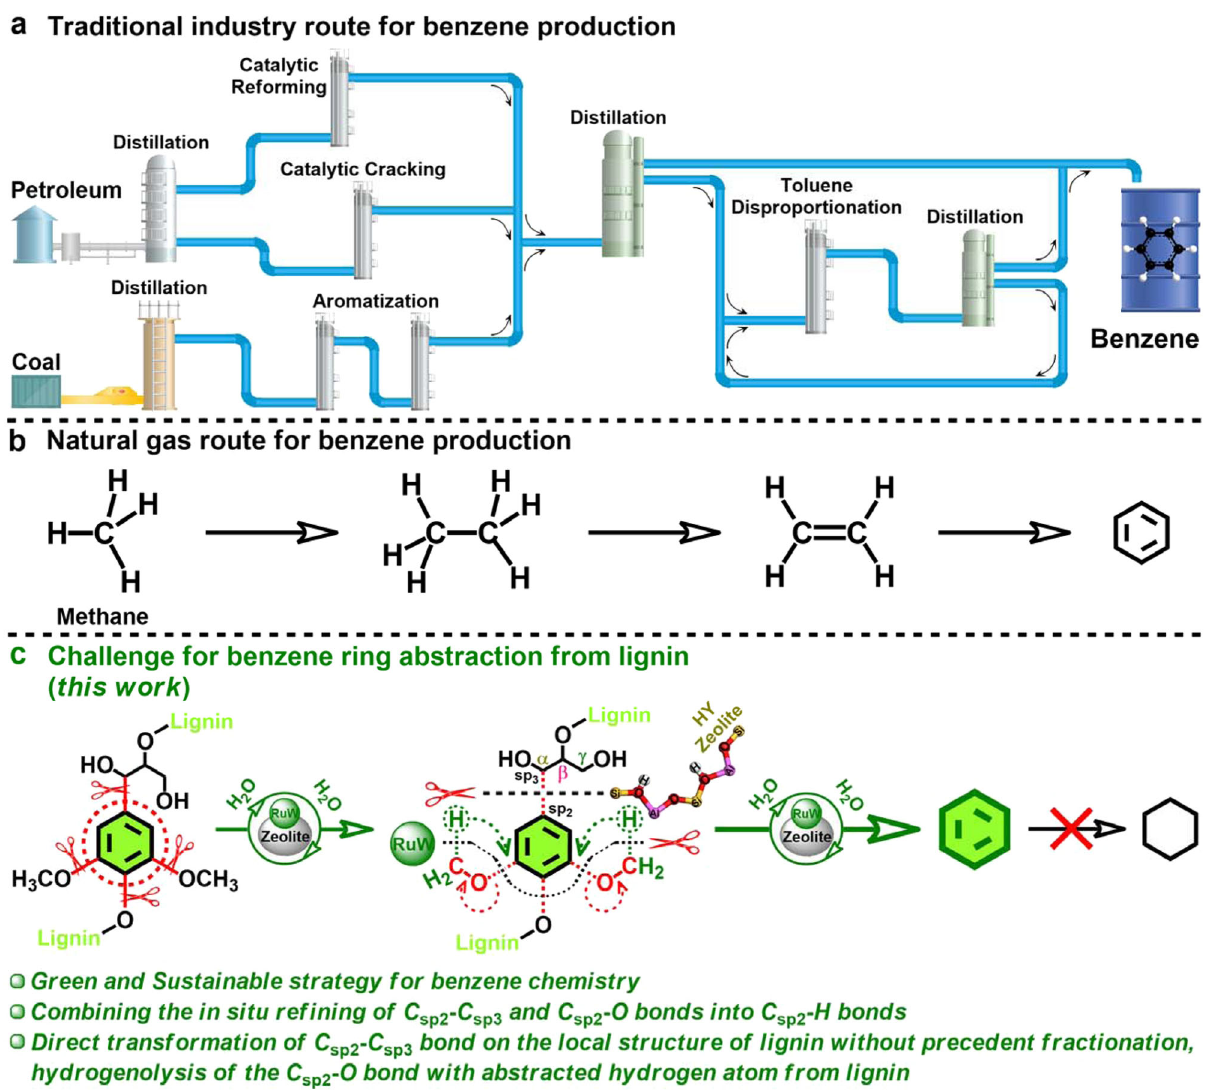
Fig. 1 Strategies employed for the benzene production. a Traditional industry route for benzene production. b Natural gas route for benzene production. c Lignin-to-benzene